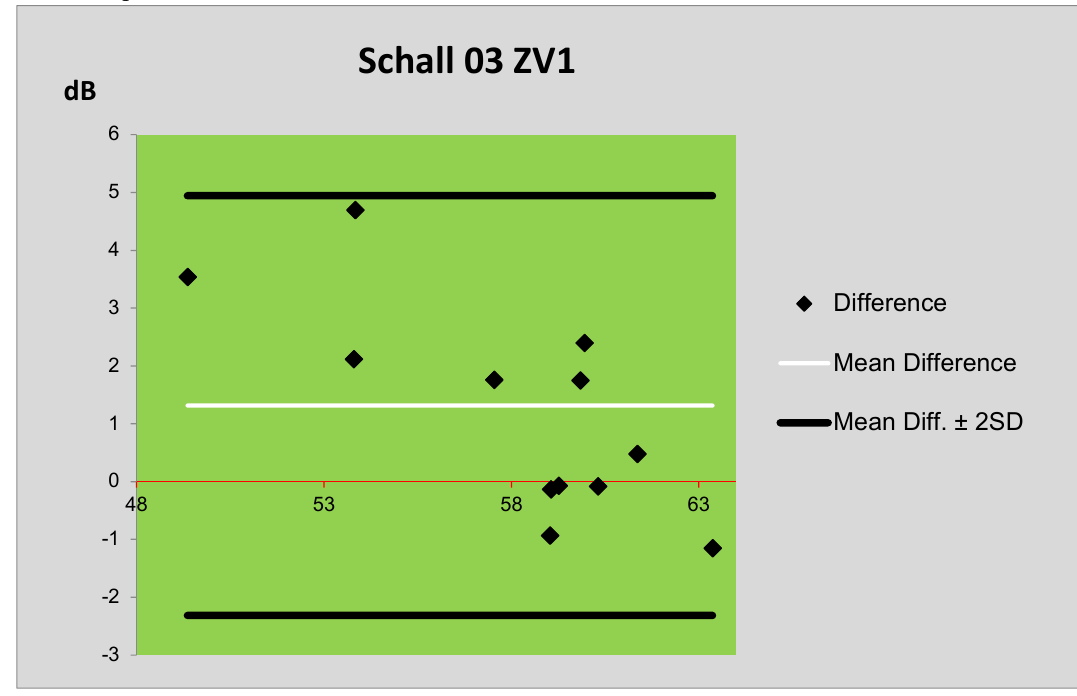
Figure 5. Bland–Altman plot of di ff erences between the prediction (Schall 03) and measurement of ZV1.